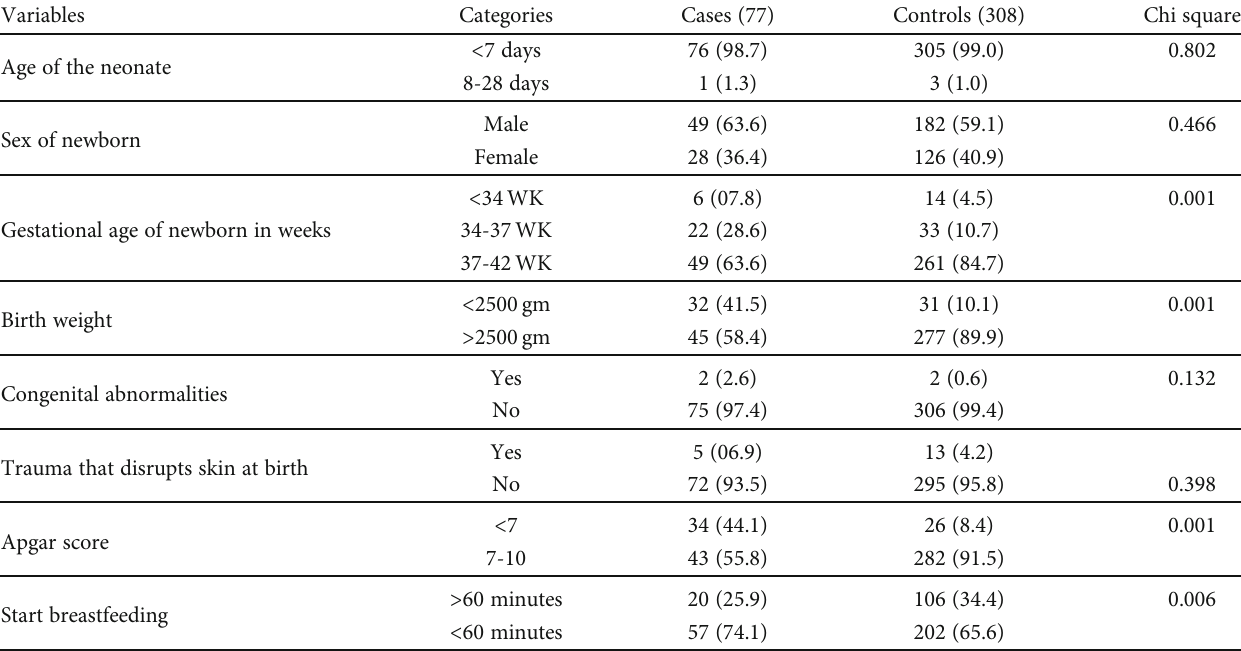
Table 3: Neonatal factors of neonatal sepsis among neonates at SCGH and WSUTRH, Wolaita Sodo town, 2019.